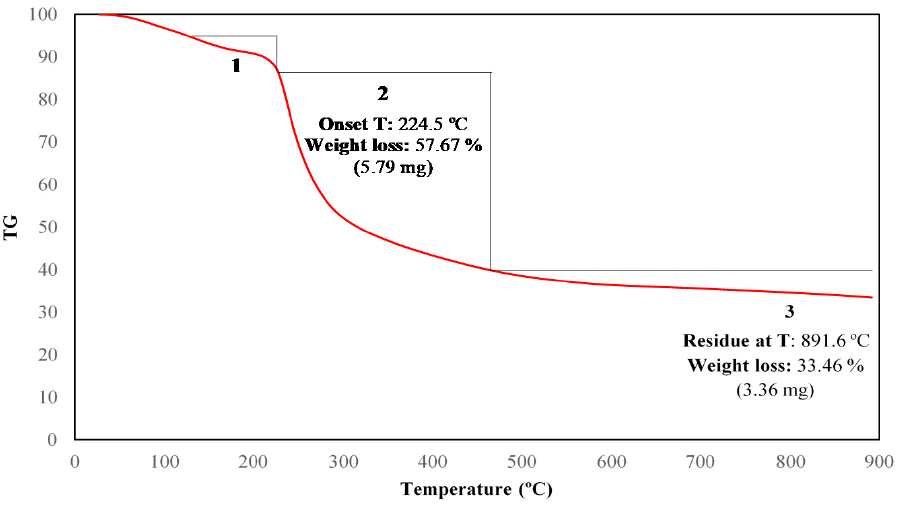
Figure 7. Thermogravimetric profile of 2:1 molar ratio inulin–TEOS hybrid